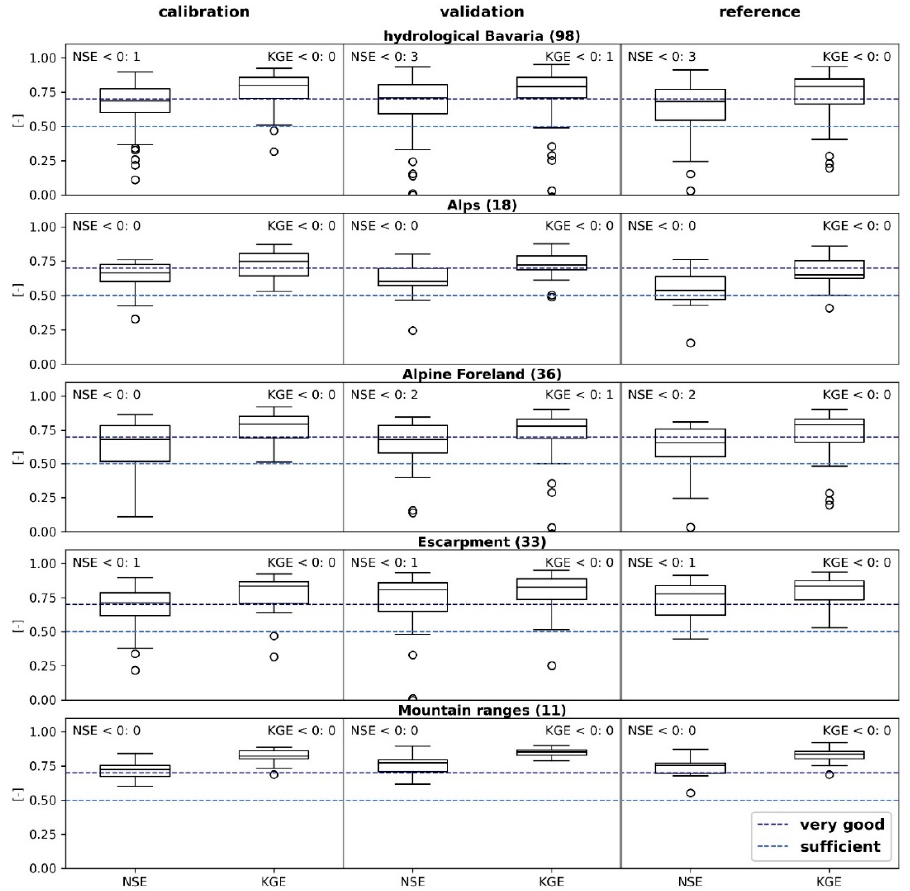
Figure 5. WaSiM model performance (NSE and KGE) for the three different periods (calibration, validation, reference period) for gauges of the Hydrological Bavaria and further subdivided by the four different landscapes (Alps, Alpine foreland, escarpment, mountain ranges). The number of gauges in each subregion is marked in brackets. The dashed lines indicate margins of a sufficient (light blue) and very good (dark blue) model fit. The values at the top of each frame indicate the number of gauges where the model performance of NSE or KGE is below zero.